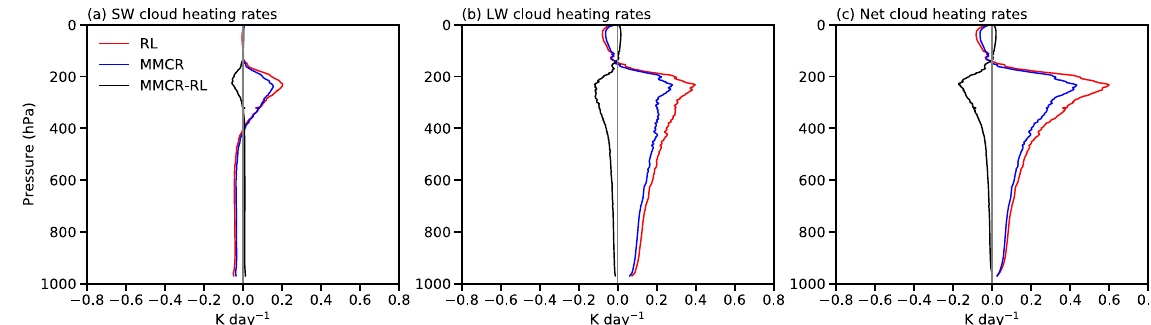
Figure 7. Mean profiles of ( a ) shortwave (SW), ( b ) longwave (LW), and ( c ) net daily-mean cloud heating rates (K day − 1 ) based on the Raman lidar (RL; red) and millimeter wavelength cloud radar (MMCR; blue) observations for transparent profiles with ice clouds only, and their differences (MMCR-RL; black) at the Southern Great Plains (SGP) site from August 2008 to January 2011.